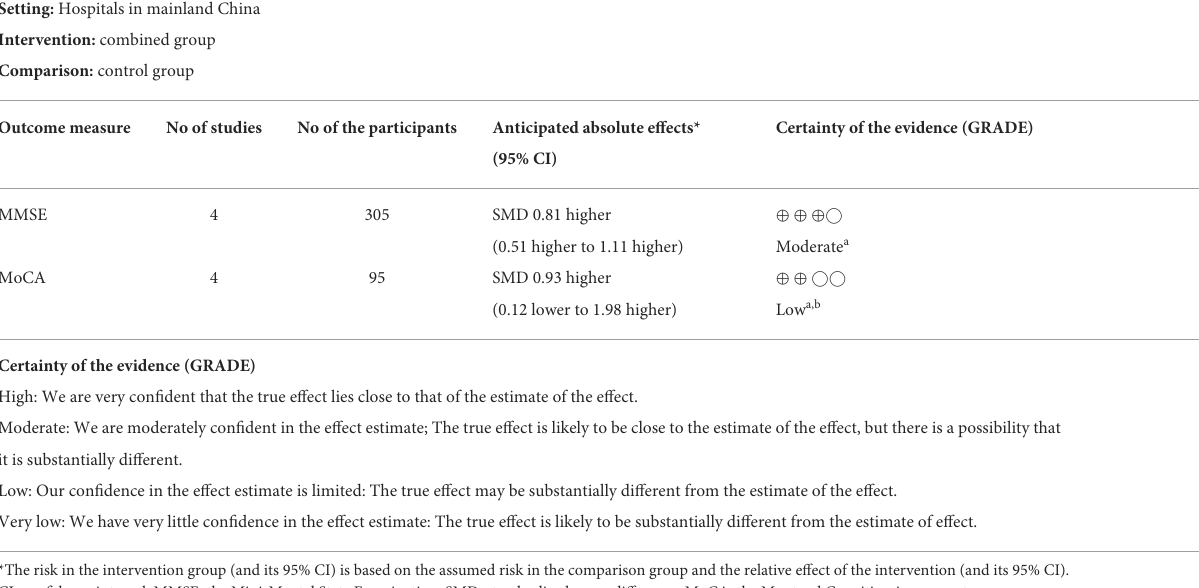
TABLE 1 Summary of the